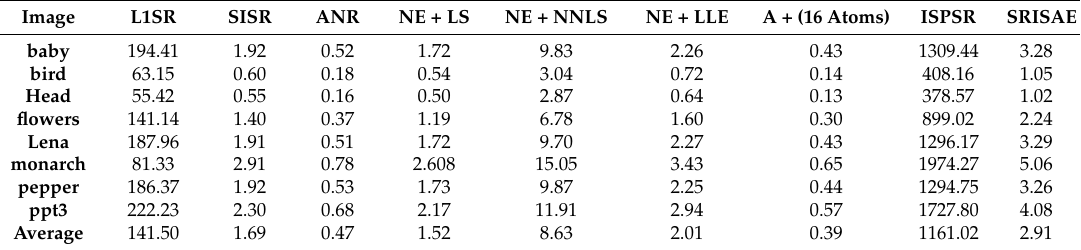
Table 4. Comparison of computing time of different SR algorithms (s).